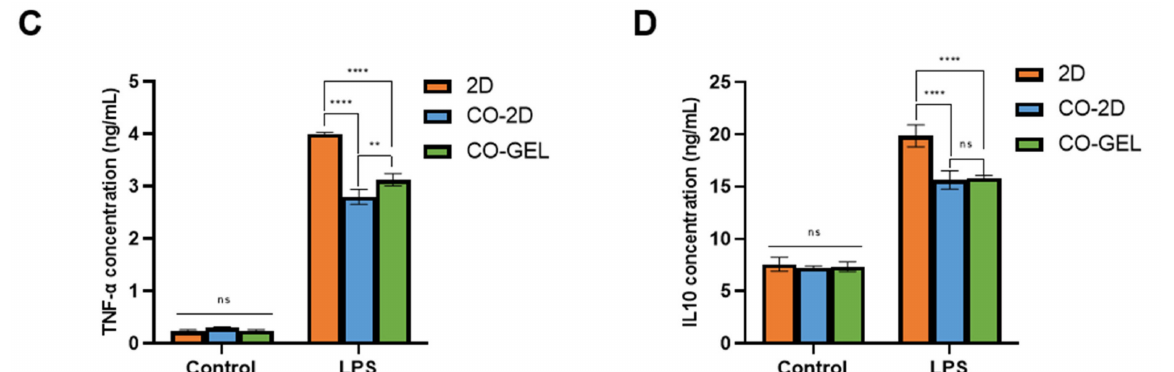
Figure 7. Immunomodulatory effect of DPSC on B-ECM hydrogel towards RAW cells under co-culture system under aseptic and septic conditions. Relative expression of TNF- α ( A ) and IL10 ( B ) genes by qPCR. ELISA assay cytokine concentration measurement of TNF- α ( C ), IL-10 ( D ) concentration in cell culture supernatant. Statistics are denoted as ns being no significant, ** p ≤ 0.01, *** p ≤ 0.001, and **** p ≤ 0.0001.